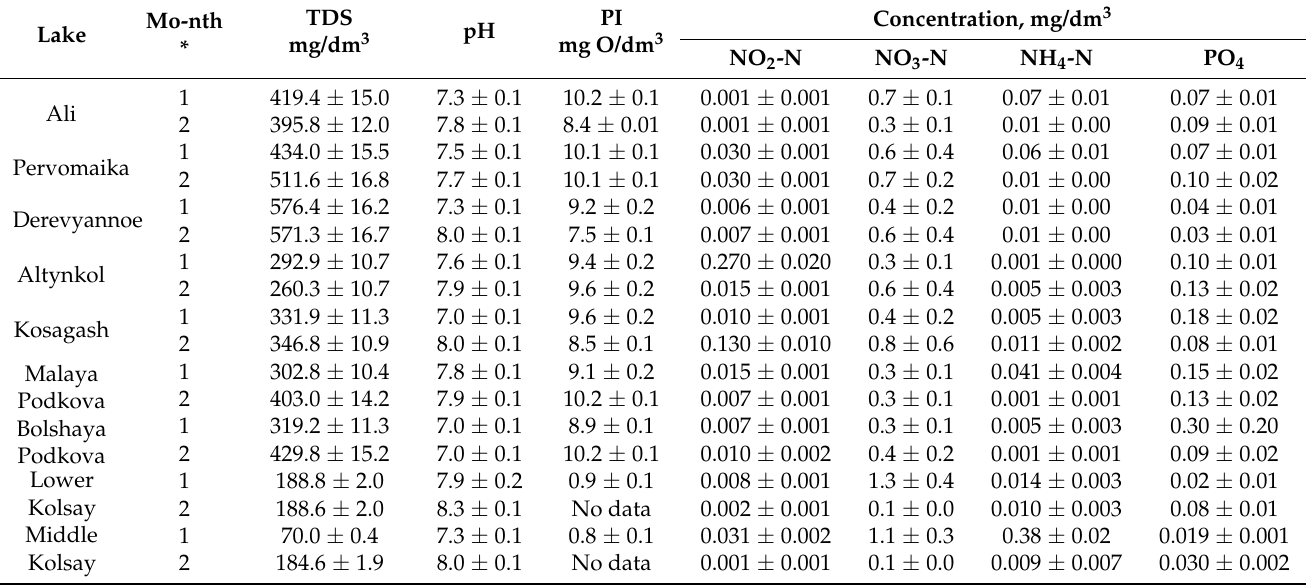
Table 2. Physical and chemical variables of small lakes in South-East Kazakhstan, mean values with standard deviation, summer 2019.